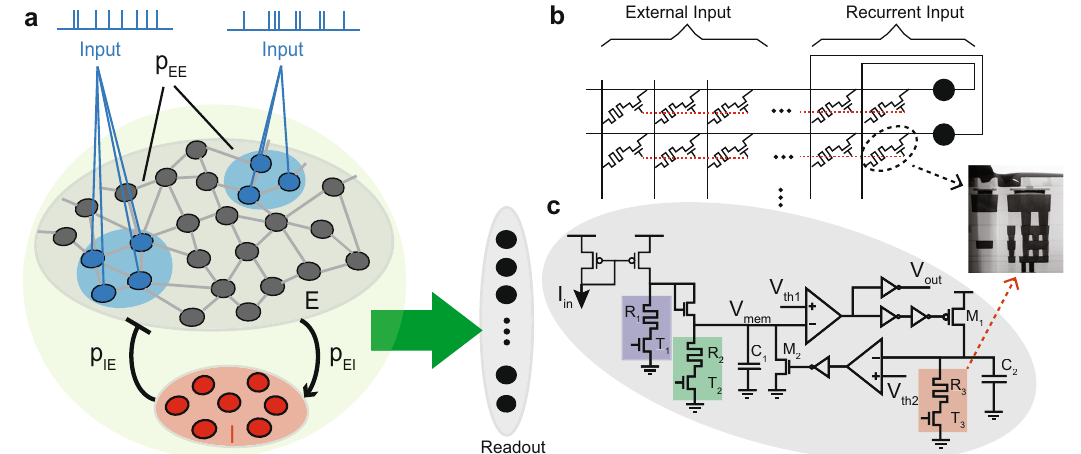
Fig. 1 | Spiking Recurrent Neural Network (SRNN) and its hardware imple- mentation. a The SRNNiscomposedofa recurrent poolof excitatory neurons (E) whose connections are formed by random fi xed weights (static) or through learning (MEMSORN). The probability ofthese connections are de fi ned as p EE . The network is excited by spatio-temporal inputs activating sub-populations, shown in blue. Each of the sub-populations encodes a particular part of the sequence. The excitatory (E, gray) and inhibitory (I, red) populations are connected to each other with probabilities p IE and p EI . There are no recurrent connections amount the inhibitorypopulations.Bothpopulationscontributetotheactivationoftheoutput, via the readout connections (green arrow). Each neuron in the readout is assigned to adifferentpredictionclass. b Apossiblehardwareimplementation of the SRNN.